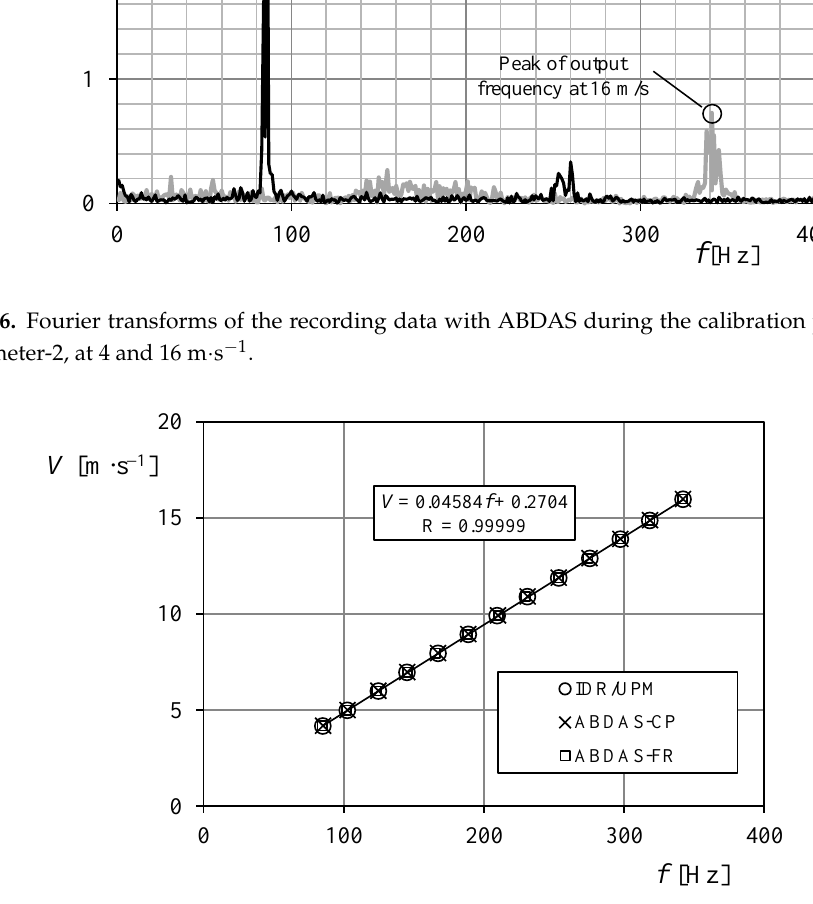
Figure 17. Calibration points of Anemometer-1, obtained from the IDR/UPM calibration system (the transfer function resulting from these data is included in the graph), and from the data measured with ABDAS and post-processed counting pulses (ABDAS-CP; see Equation (6)) and using the Fourier transform (ABDAS-FR; see Equation (7)). Table 5. Calibration coefficients, A, B, and correlation coefficient R , (see Equation (5)) resulting from the calibrations performed to Anemometers 1–3. The coefficients included in the table are the ones obtained from the IDR/UPM accredited calibration process, and the ones from the data measured with ABDAS and post-processed counting pulses (ABDAS-CP; see Equation (6)) and using the Fourier transform (ABDAS-FR; see Equation (7)).